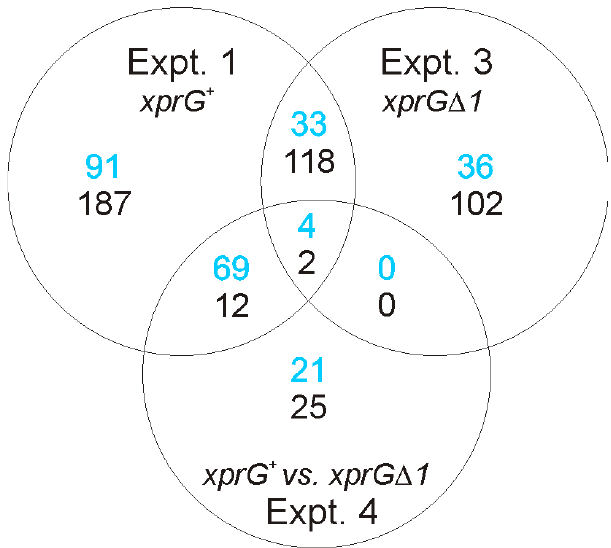
Figure 2. Venn diagram showing the number of probes hybridising to differentially expressed transcripts in different Aspergillus nidulans genotypes. In Experiments 1 and 3, the number of transcripts up-regulated during carbon starvation is shown in blue and the number down-regulated is shown in black. In Experiment 4, the number of transcripts that are down-regulated in the xprG D 1 mutant is shown in blue and number up-regulated is shown in black.